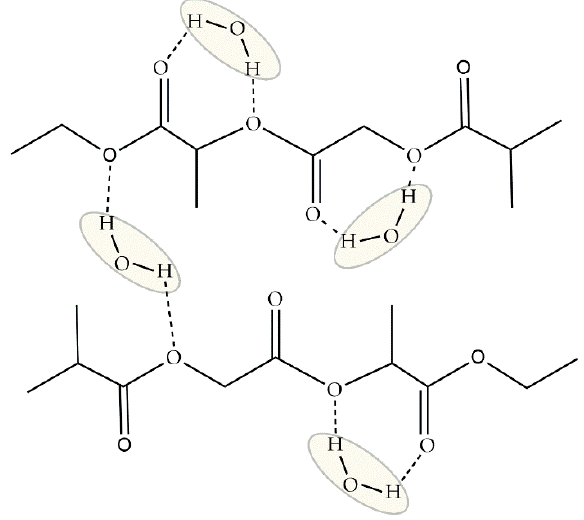
Figure 17. Proposed structure of non-freezable water sorbed on PLGA.